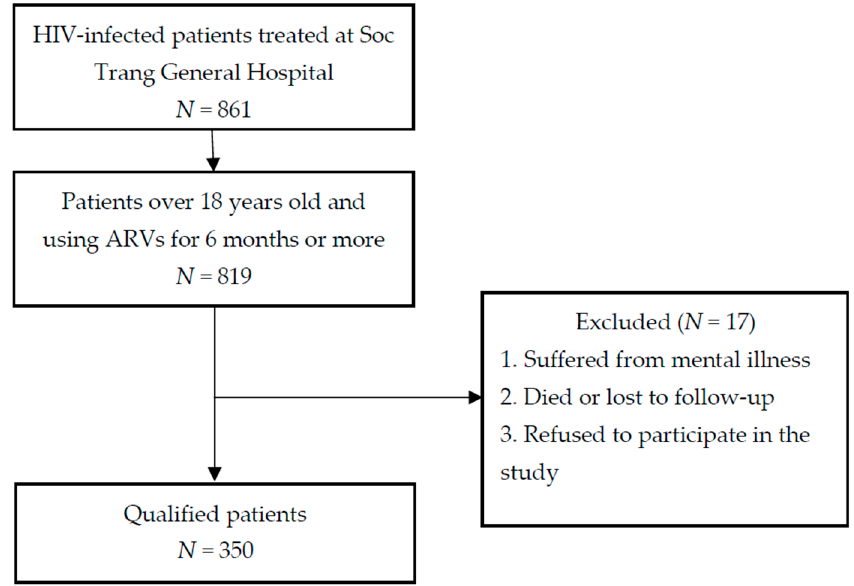
Figure 1. Enrollment of participants. Table 1. Study population characteristics: demography, antiretroviral (ARV) treatment, and medical services and support.